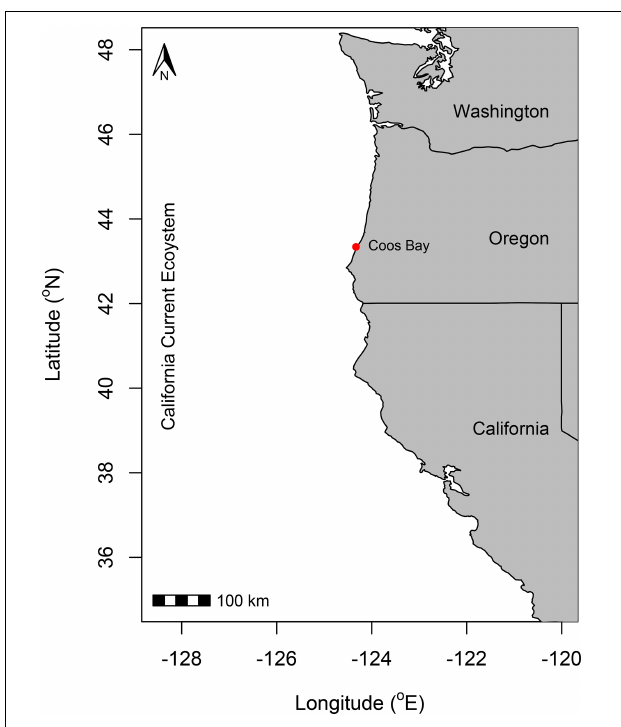
FIGURE 2 | Location of the Dungeness crab megalopae sampling site, Coos Bay, Oregon, United